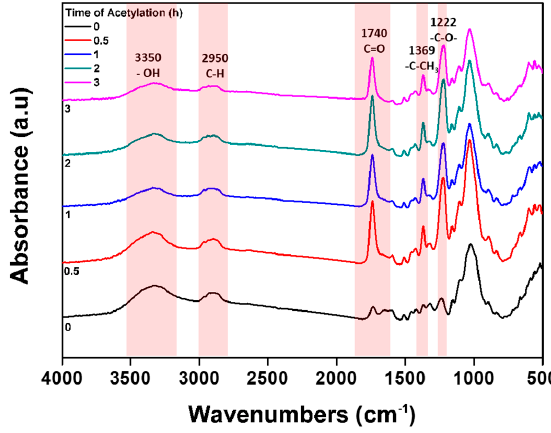
Figure 3. Infrared spectroscopy of untreated and acetylated kenaf fibers.